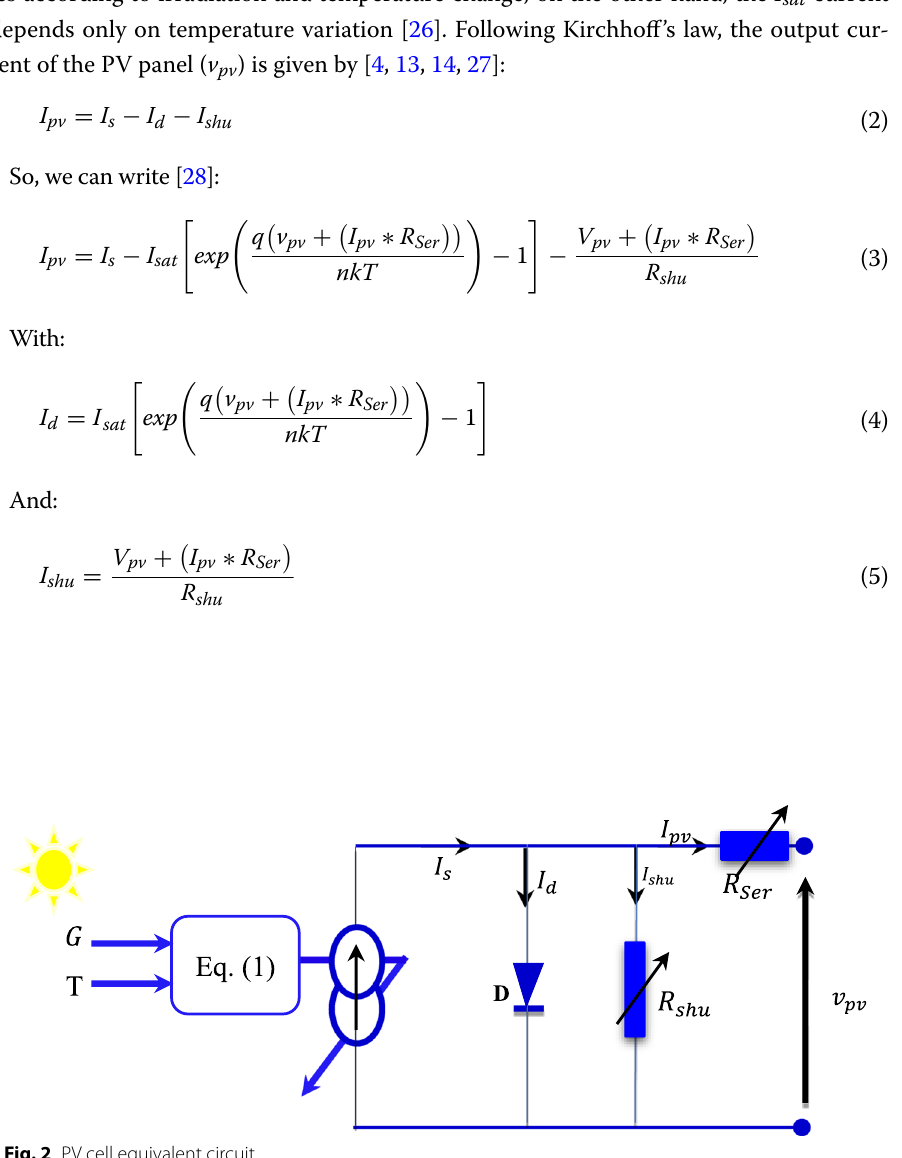
Fig. 2 PV cell equivalent